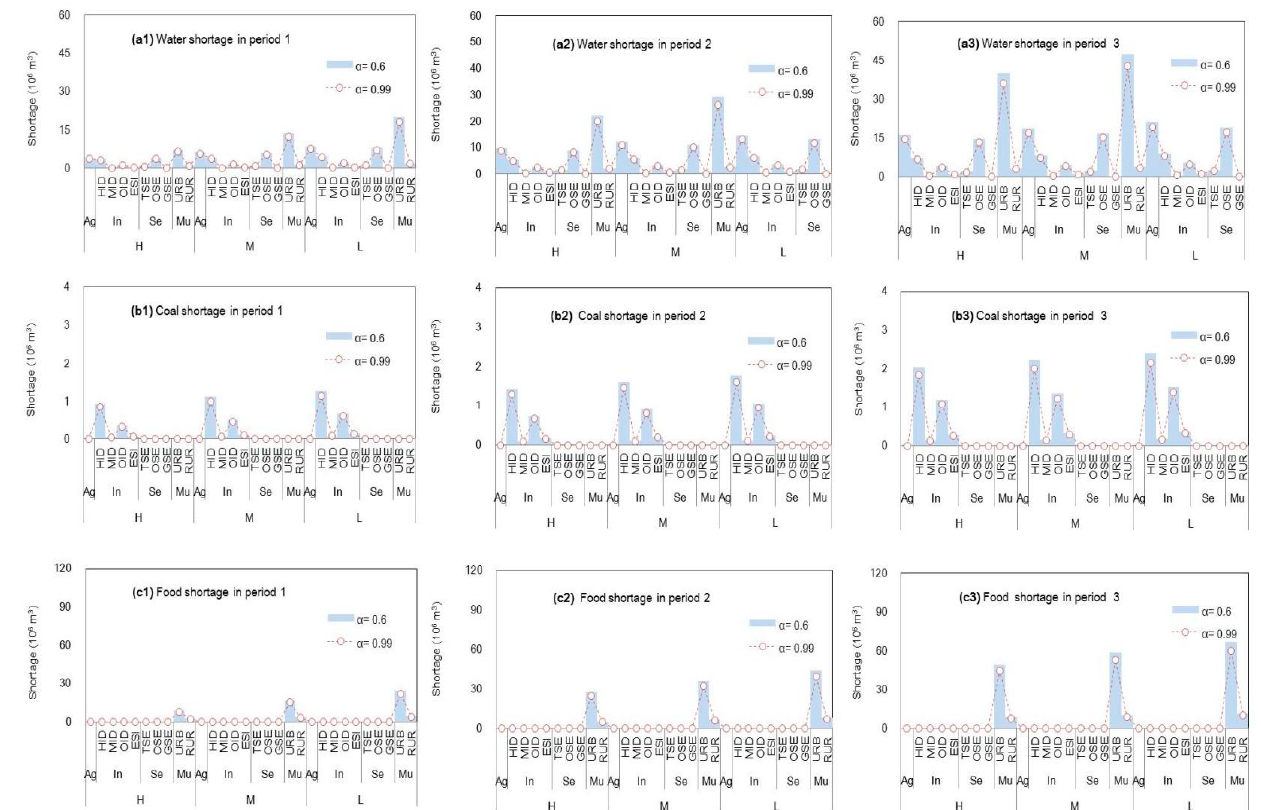
Figure 3. Total water–food–energy shortages among various sectors under S0 ( α = 0.6 and β = 0.99) (agricultural sector denoted as “Ag”, industrial sector denoted as “In”, service sector denoted as “Se”, municipal sector denoted as “Mu”; heavy-consumption industry plant denoted as “HID”, medium-consumption industry plant denoted as “MID”, other industry plant denoted as “OID”, energy-supply industry plant denoted as “ESI”, traditional service industry plant denoted as “TSE”, other service industry plant denoted as “OSE”, environmental protection industry plant denoted as “GSE”, urban municipal consumption plant denoted as “URB”, rural consumption plant denoted as “RUR”; high level of resource availability denoted as “H”, medium level of resource availability denoted as “M”, low level of resource availability denoted as “L”) (( a1 – a3 ) are water shortages in various periods; ( b1 – b3 ) are the coal shortages in various periods; ( c1 – c3 ) are the food shortages in various